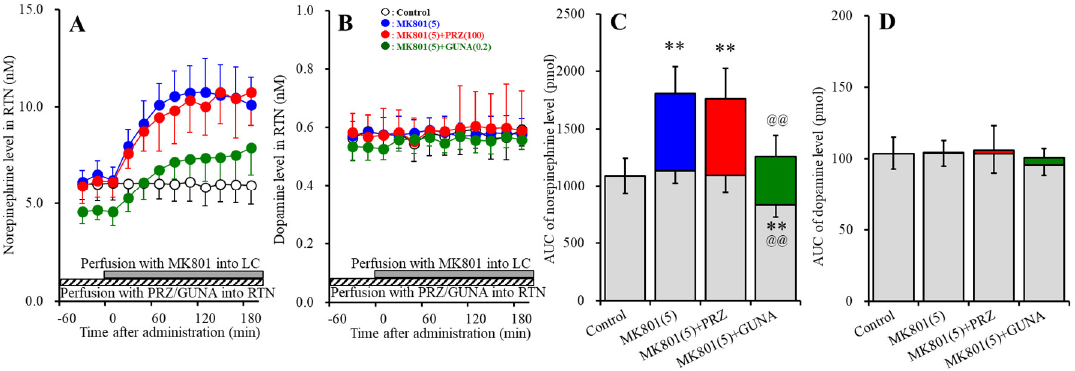
Figure 6. Effects of local administration of PRZ and GUNA into the RTN on MK801-induced releases of norepinephrine ( A ) and dopamine ( B ) in the RTN. Ordinates: mean ± SD (n = 6) of extracellular catecholamine levels (nM); abscissa: time after MK801 administration (min). Stripped bars indicate perfusion with 100 μM PRZ or 0.2 μM GUNA into the RTN. Gray bars indicate perfusion with 5 μM MK801 into the LC. ( C , D ) indicate AUC values of extracellular levels of norepinephrine and dopamine (pmol) after perfusion with MK801 (from 20 to 180 min), based on ( A ) and ( B ), respectively. Gray columns represent the AUC values before perfusion with MK801 (basal release). ** p < 0.01; relative to control, and @@ p < 0.01; relative to MK801 (5 μM) by MANOVA with Tukey’s post hoc test.